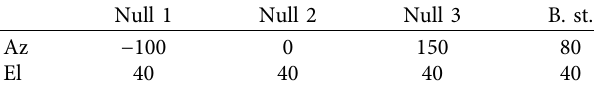
Table 4: Nulling and beam steering directions (in degrees). No-